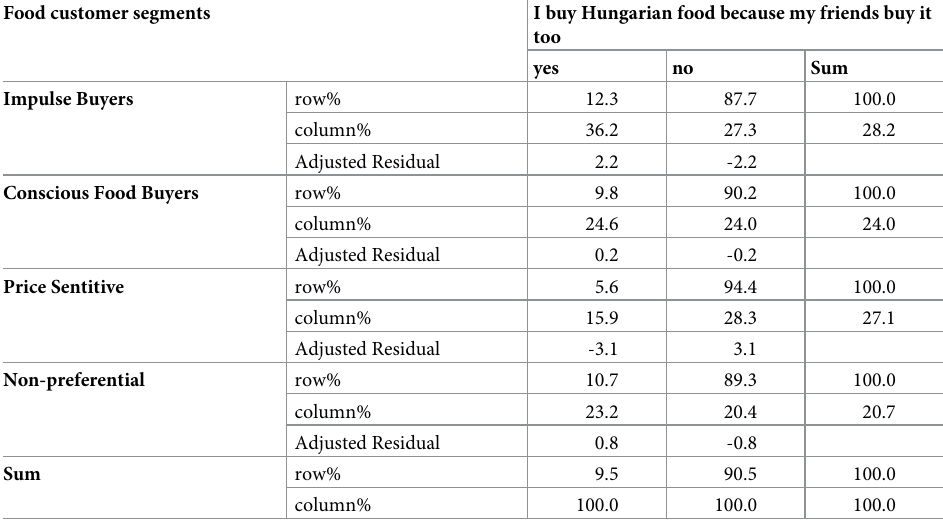
Table 9. Purchasing Hungarian food under the influence of friends among food shopping segments. Food customer